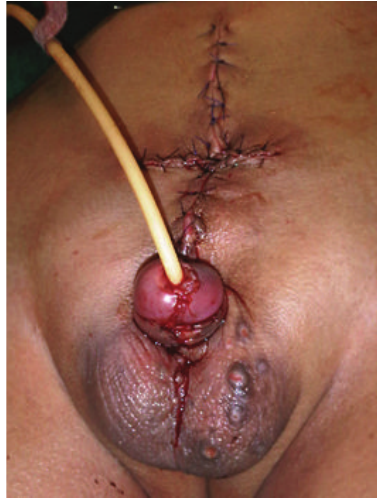
Figure 2: Final result after